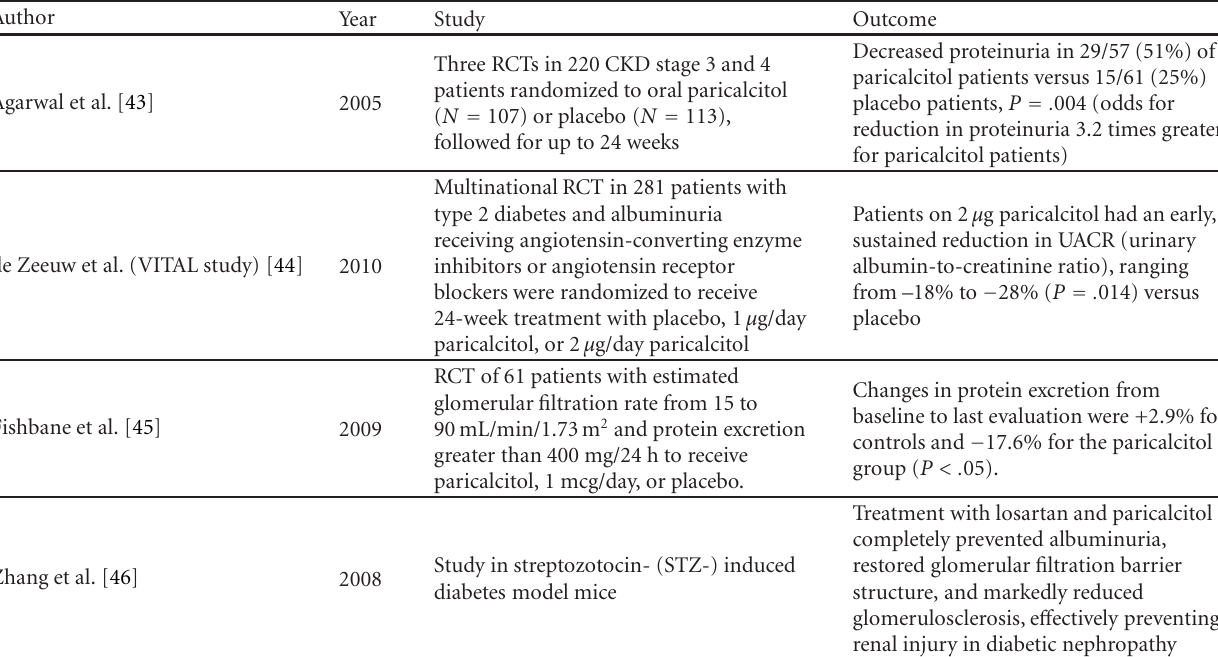
Table 10: Renal protection and reduction of proteinuria.